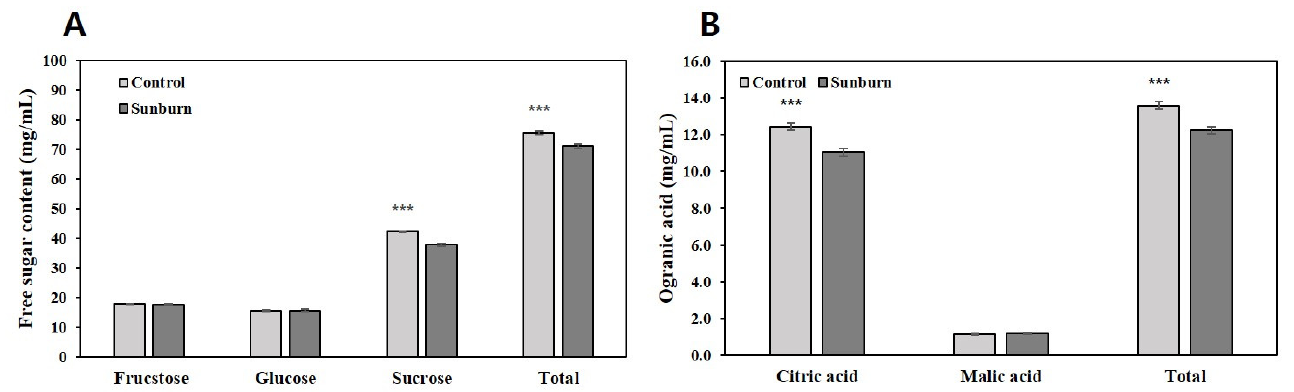
Figure 6. Comparison of free sugar and organic acid contents in sunburned and non-sunburned (control) Satsuma mandarin fruits. The values represent mean ± SE of 30 replicates. *** p < 0.001 (Student’s t -test).